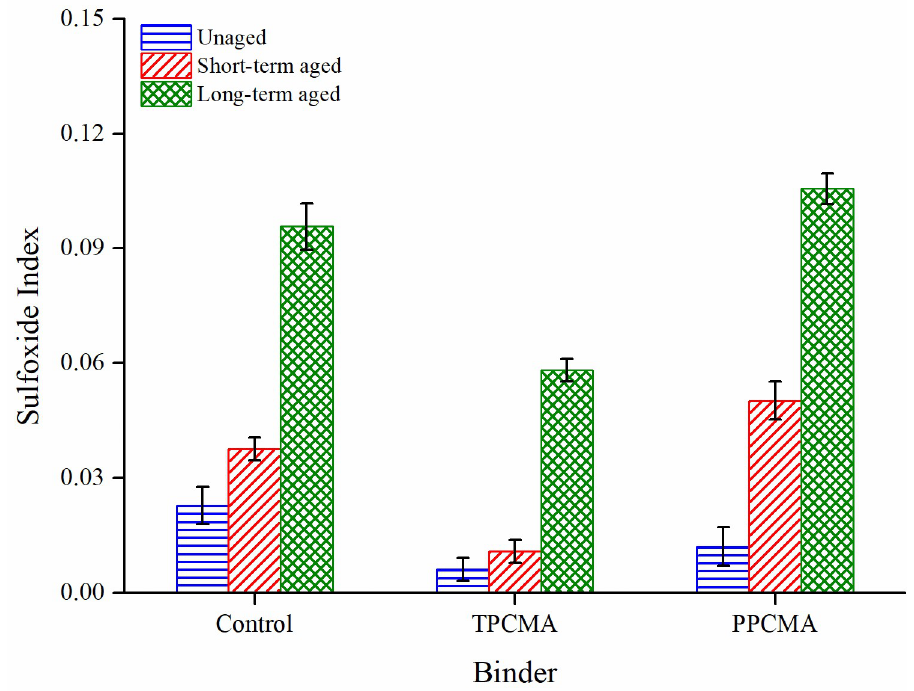
Fig 14. Sulfoxide index under different aging states.